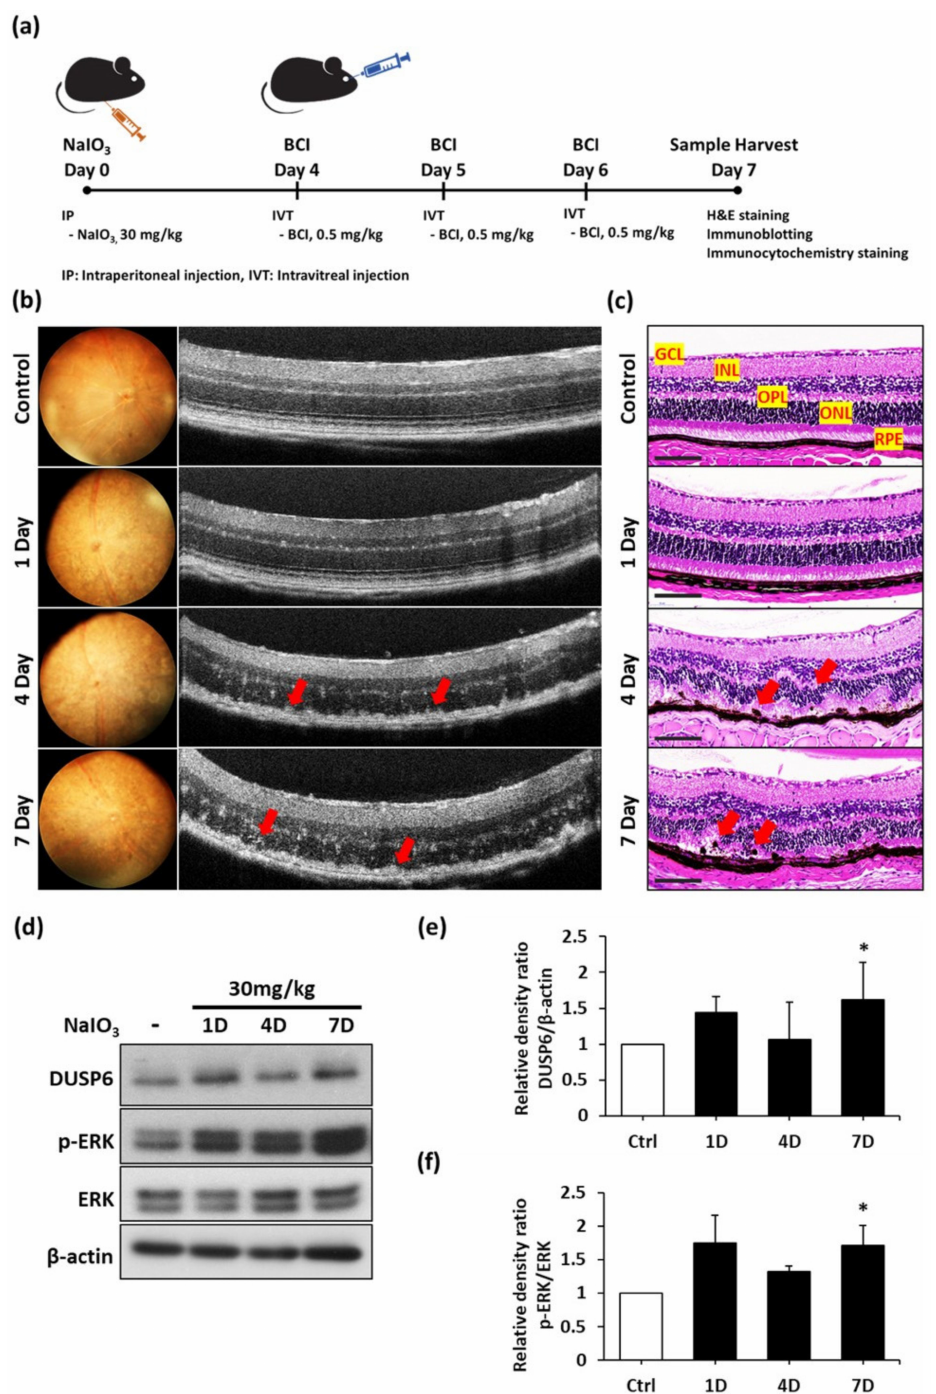
Figure 4. DUSP6/p-ERK axis was upregulated in NaIO 3 -induced retinal degeneration in vivo. ( a ) Schematic diagram illustrating the drug treatment and tissue preparation. ( b ) Real-time funds and retinal structures at different times post NaIO 3 injection were observed by fundoscopy and OCT system. The red arrows indicate the irregulated structure on the RPE layer. Representative data from three independent experiments are shown. ( c ) H&E staining presenting the mice retinal structures after treatment with NaIO 3 . The abnormal deposits on the RPE layer is represented by the red arrows. Scale bar = 50 µ m. ( d ) Representative blots showed the DUSP6/p-ERK axis expression level after NaIO 3 injection in C57BL/6 mice. ( e , f ) A quantitative analysis is shown in ( d ). * p <